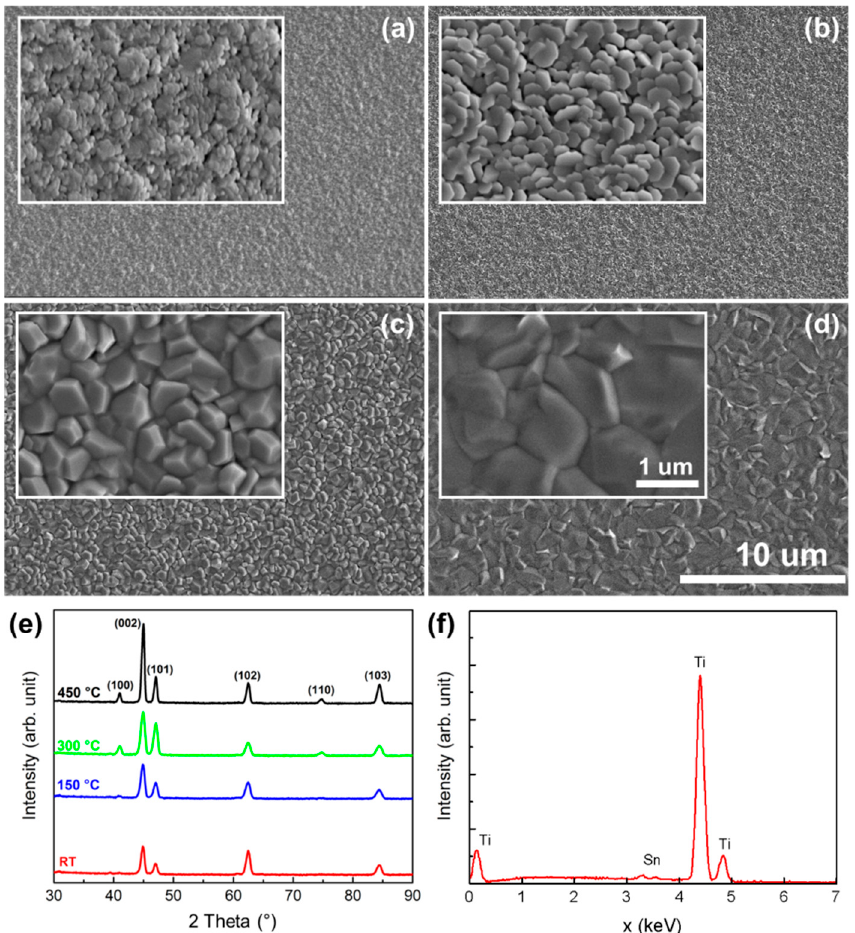
Figure 2. Scanning electron microscope (SEM) images of titanium samples deposited without substrate heating at ( a ) RT, ( b ) 150 ◦ C, ( c ) 300 ◦ C and ( d ) 450 ◦ C. ( e ) X-ray diffraction (XRD) spectra of all deposited Ti films; ( f ) energy dispersive X-ray spectroscopy spectrum of titanium film deposited at 150 ◦ C on fluorine-doped tin oxide (FTO) substrate.